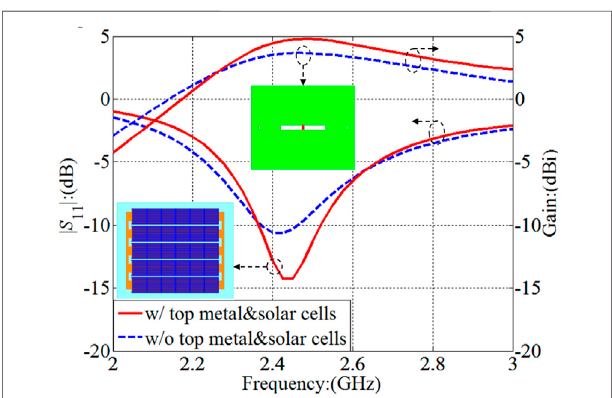
FIGURE 5 | The in fl uence of top metal and solar cells on the antenna performance of the lower band.